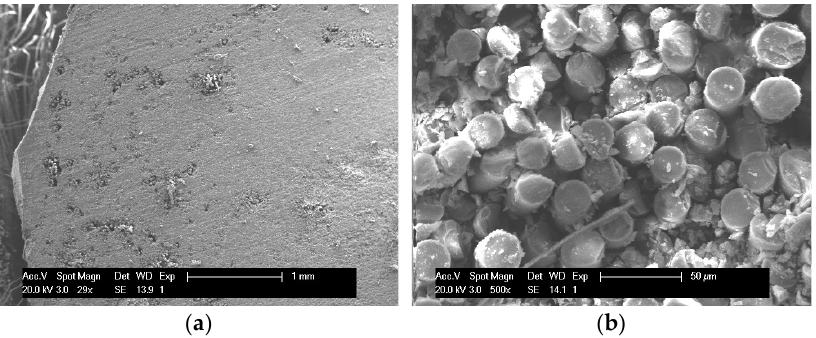
Figure 12. The microstructure of G1 after accelerated aging at 60 °C for 180 days: ( a ) 29 × G1; ( b ) 500 × G1.